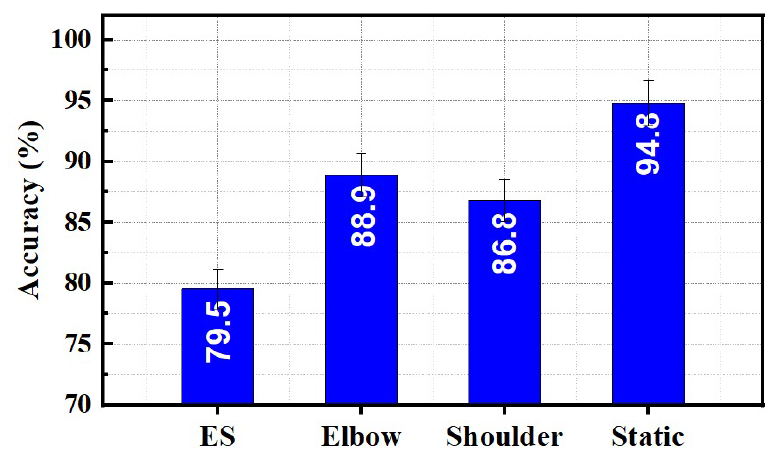
Figure 9. Comparison of static and dynamic protocol on hand gestures classification performance.